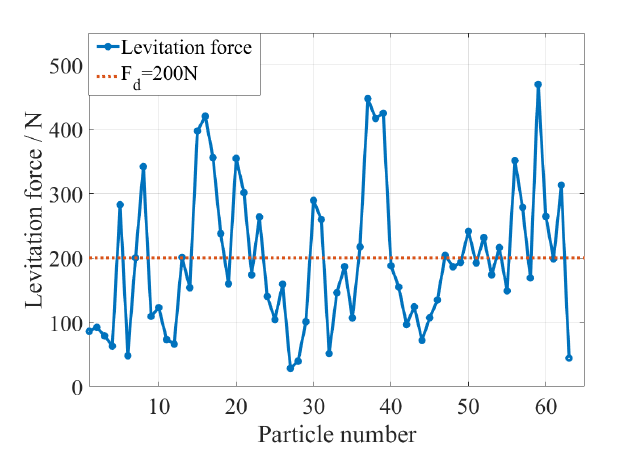
Figure 18. Levitation force of each solution.